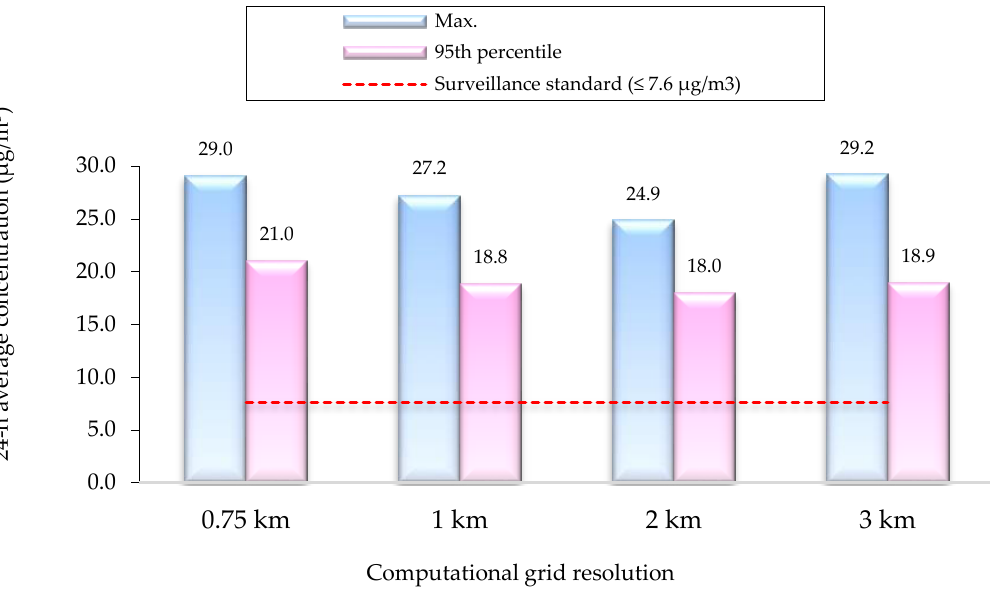
Figure 2. The maximum and the 95th percentile of 24-h average concentrations of benzene from 4 different grid resolutions.